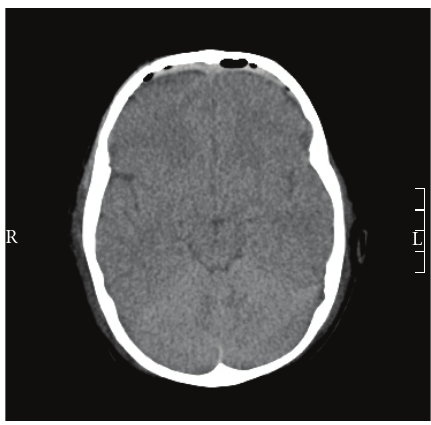
Figure 4: Postoperative control axial CT